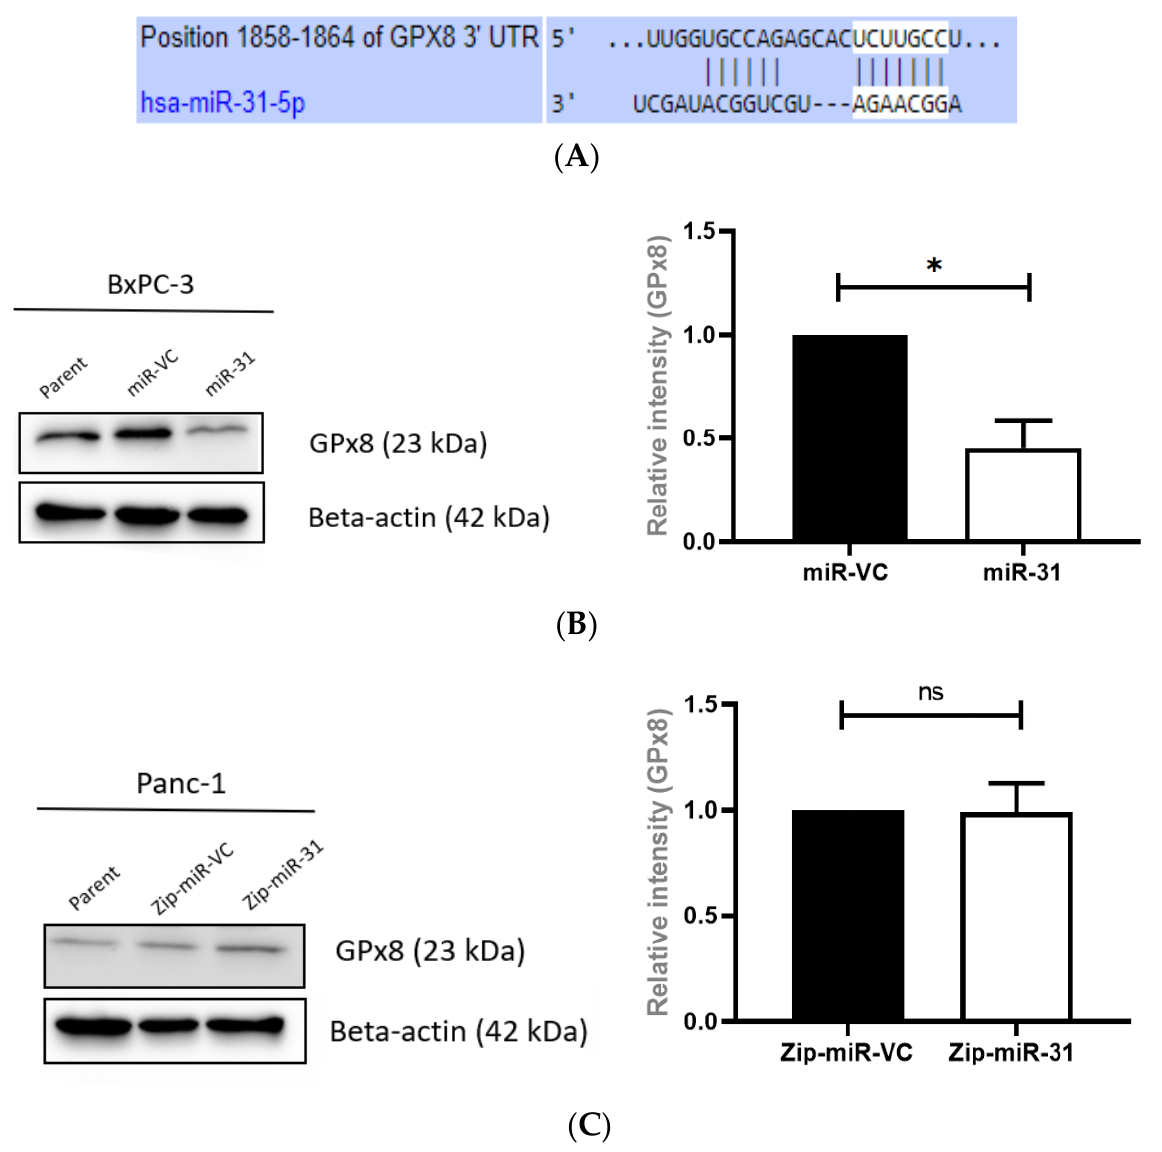
Figure 9. Manipulating miR-31 in PDAC cells alters the expression of GPx8. ( A ) The putative binding site for miR- 31 in the 3′UTR of GPx8. ( B ) Representative Western blot illustrating GPx8 levels in BxPC-3 cells. Overexpressing miR-31 in BxPC-3 cells significantly reduced GPx8 levels compared to its vector control equivalent (* p = 0.0279). ( C ) Representative blot illustrating GPx8 levels in Panc-1 models. Suppressing miR-31 in Panc-1 cells does not significantly alter GPx8 levels ( ns p = 0.947) compared to its vector control equivalent. Data are expressed as the mean ± SEM and were analyzed by a one-sample t -test ( n = 3). 3.8. Silencing GPx8 Enhances Radiosensitivity in BxPC-3